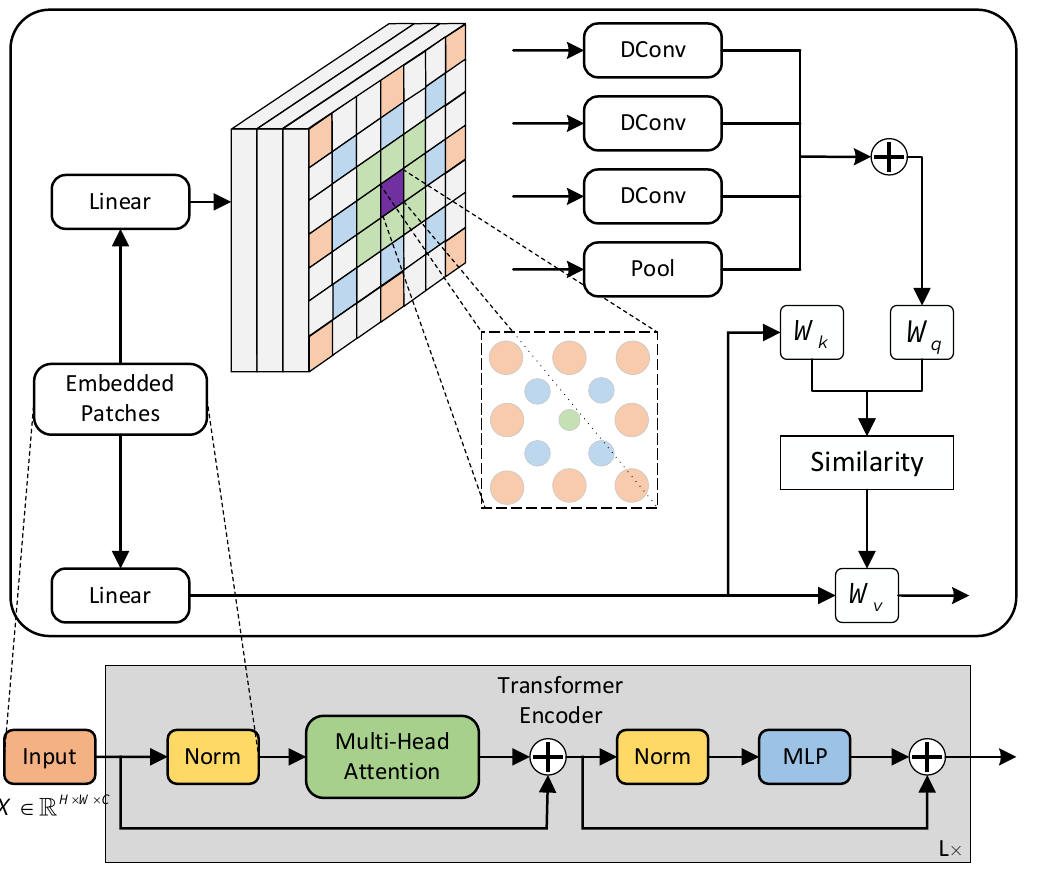
Figure 3. Multiscale query Transformer.